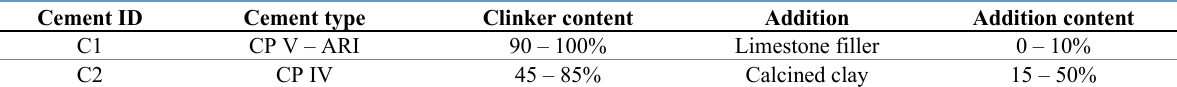
Table 1. Cement types and their proportions according to the Brazilian standard NBR 16697 [29].